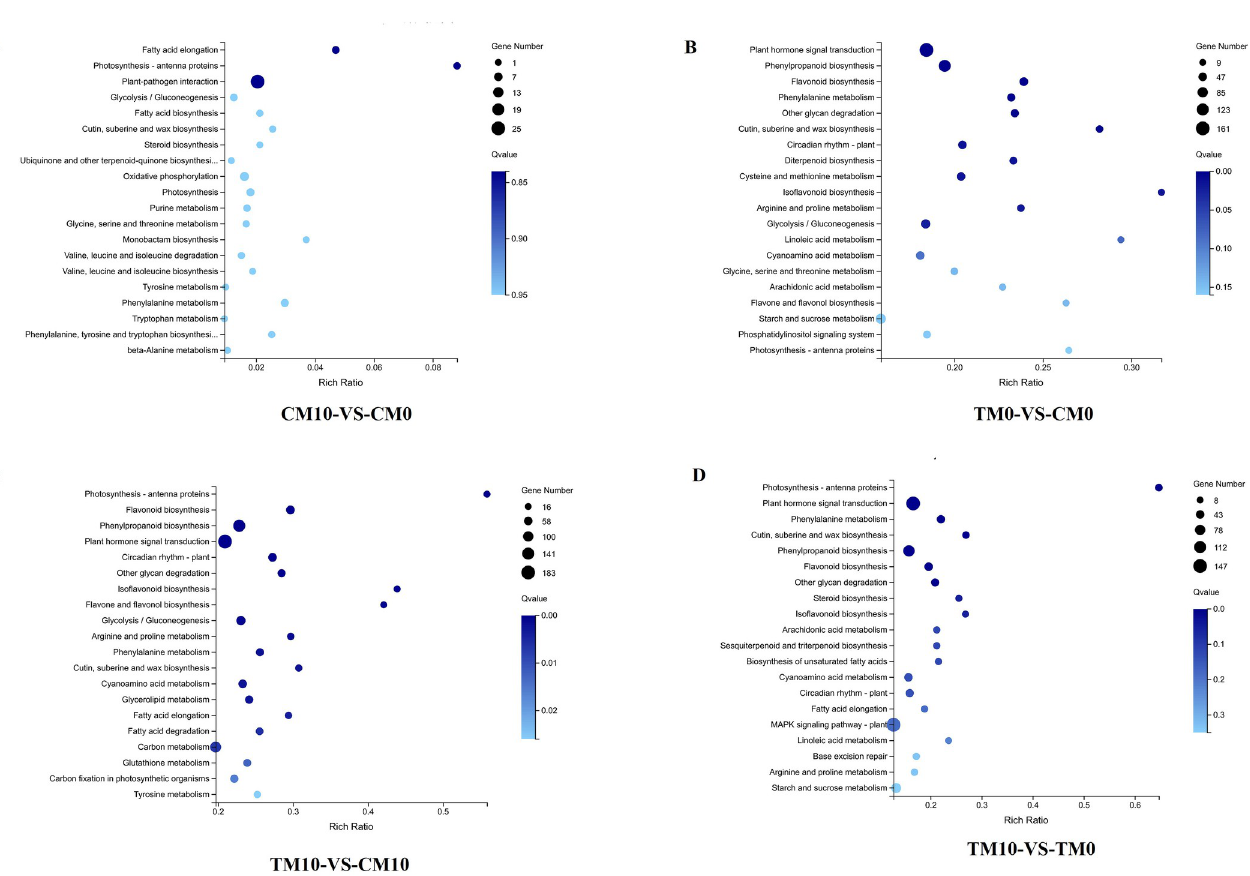
Fig 5. Enrichment bubble diagram in KEGG pathway of DEGs in the four groups (CM10-vs-CM0, TM0-vs-CM0, TM10-vs-CM10, TM10-vs-TM0). The enrichment of KEGG pathway showed with bubble diagrams from three dimensions. The default is the first 20 GO terms with the lowest Qvalue or the selected GO terms (sorted by Qvalue, up to 60). A. KEGG pathway enrichment bubble diagram in the comparison group of CM10-vs-CM0. B. KEGG pathway enrichment bubble diagram in the comparison group of TM0-vs-CM0. C. KEGG pathway enrichment bubble diagram in the comparison group of TM10-vs- CM10. D. KEGG pathway enrichment bubble diagram in the comparison group of TM10-vs-TM0.